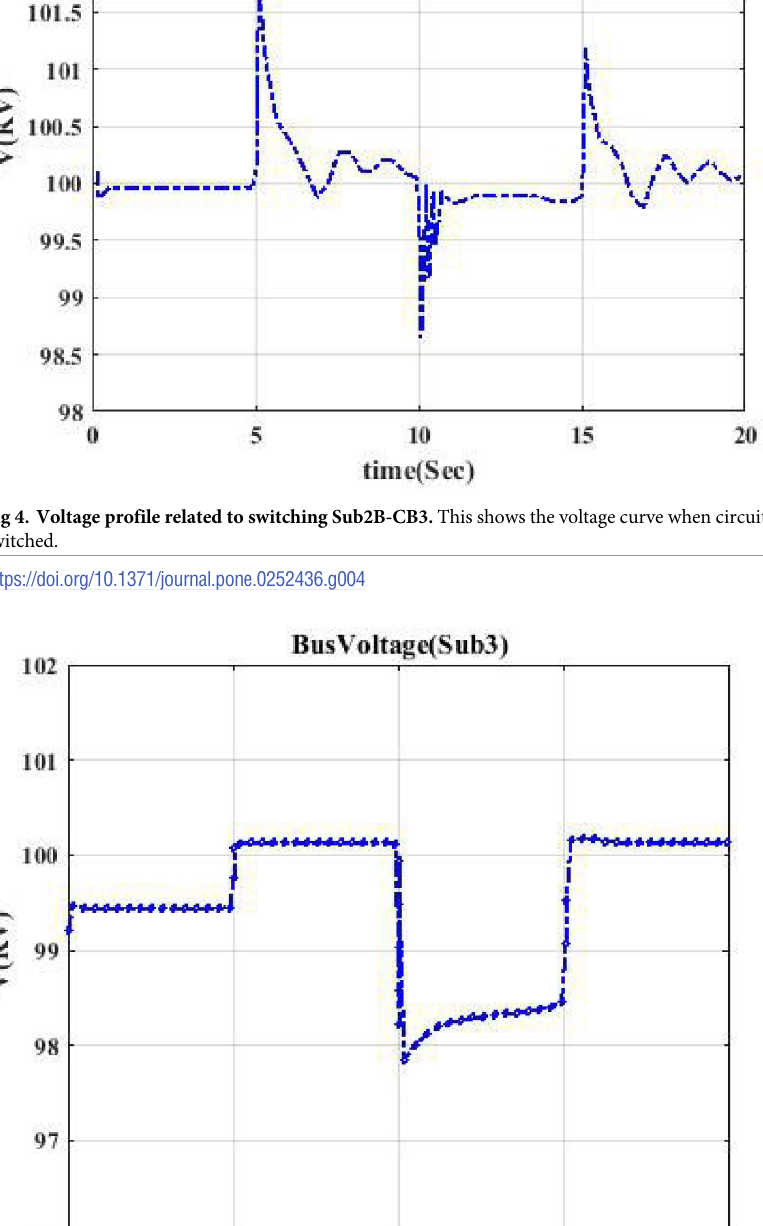
PLOS ONE | https://doi.org/10.1371/journal.pone.0252436 June 1,